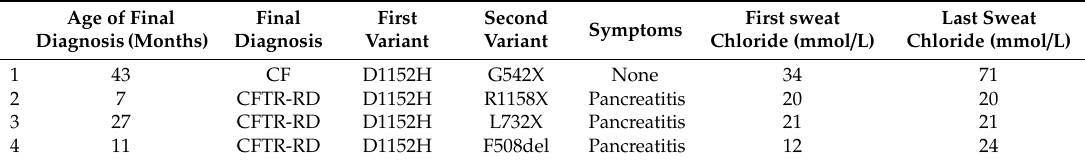
Table 3. Characteristics of CRMS / CSPID subjects who progressed to CFTR-RD /